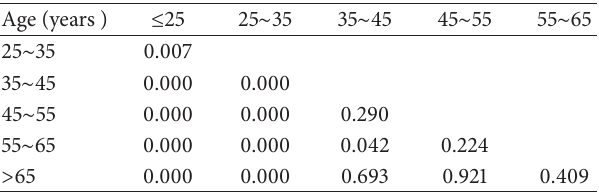
Table 3: The statistical analysis among groups grouped by